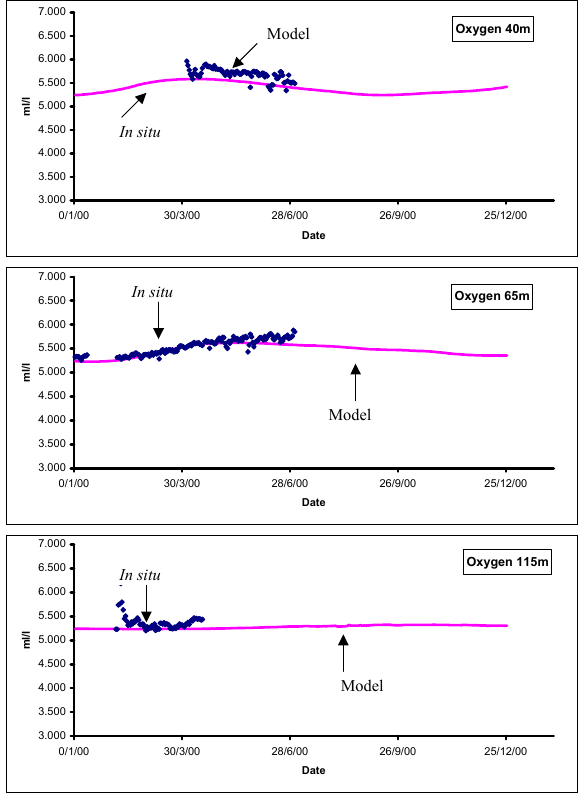
Fig. 6. Validation of model oxygen concentration with CTD mea- surements at 40, 65, and 115m.